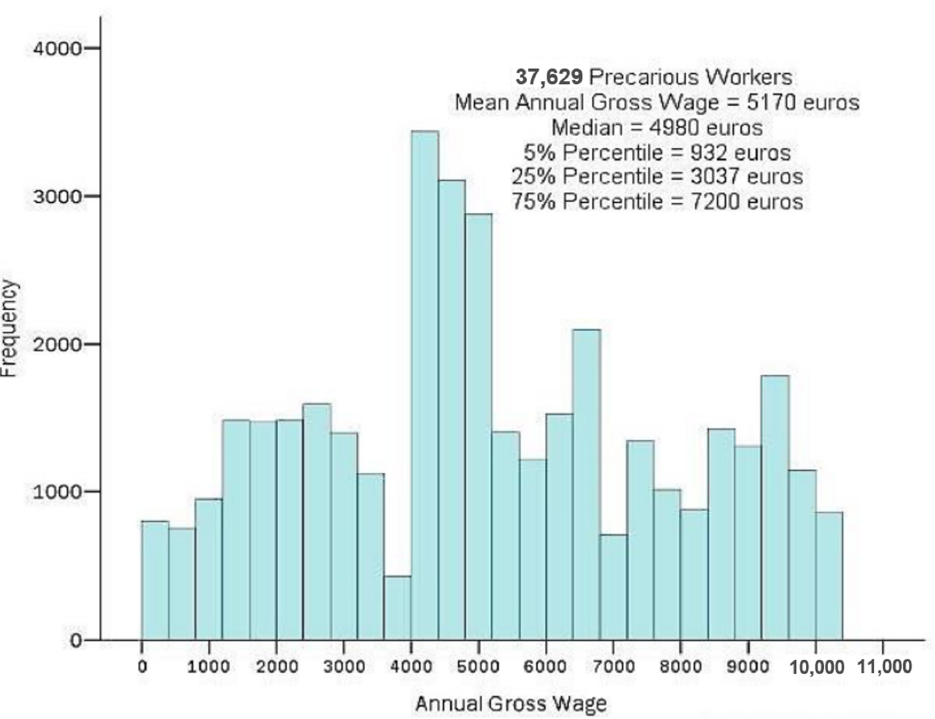
Figure 10. Distribution of precarious workers by annual gross labour income (2019). Data source: EU-SILC (2020). Eurostat (2020).